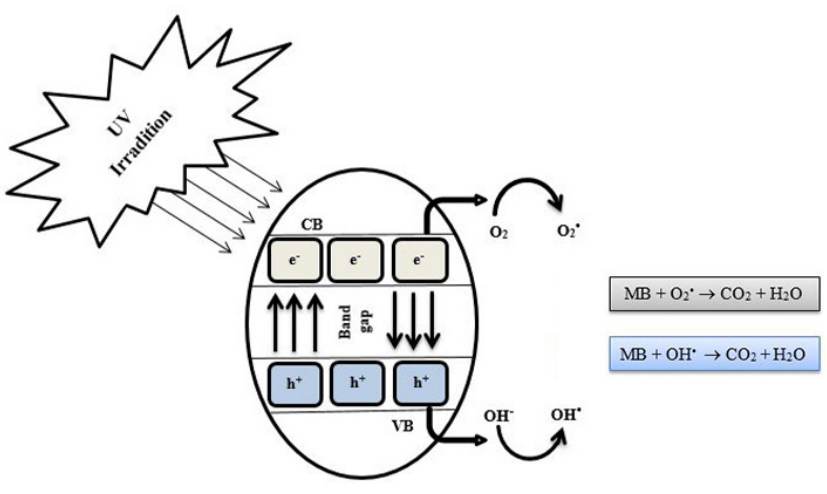
Figure 9. Schematic representation of photocatalytic degradation of methylene blue by WO 3 /GO nanocomposites under UV irradiation